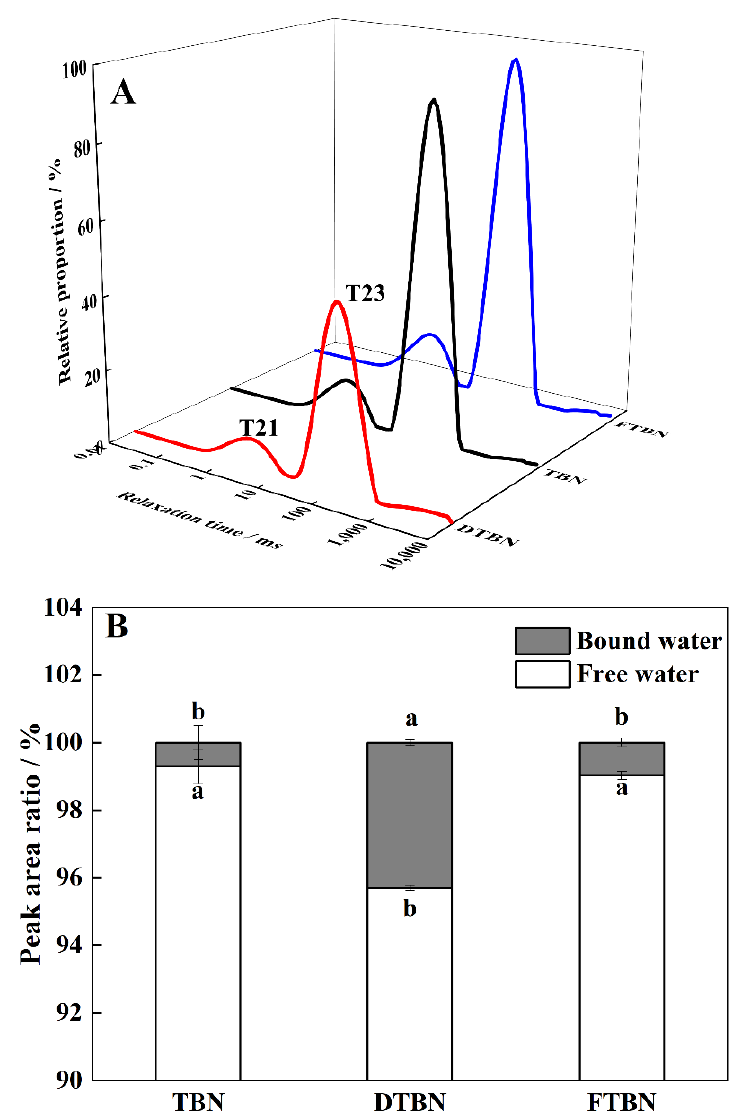
Figure 2. Water distribution of Tartary buckwheat noodles boiled at the optimum cooking time. Curves of T2 relaxation time ( A ); the peak area ratio of T2 ( B ). TBN, fresh Tartary buckwheat noodles; DTBN, dried Tartary buckwheat noodles; FTBN, frozen Tartary buckwheat noodles. Different letters in the same figure imply that the values are significantly different ( p < 0.05).